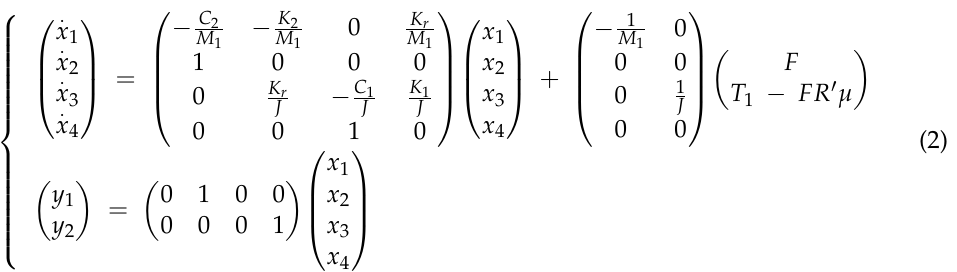
Figure 4. Simplified model of F3 vertical–torsional coupling .